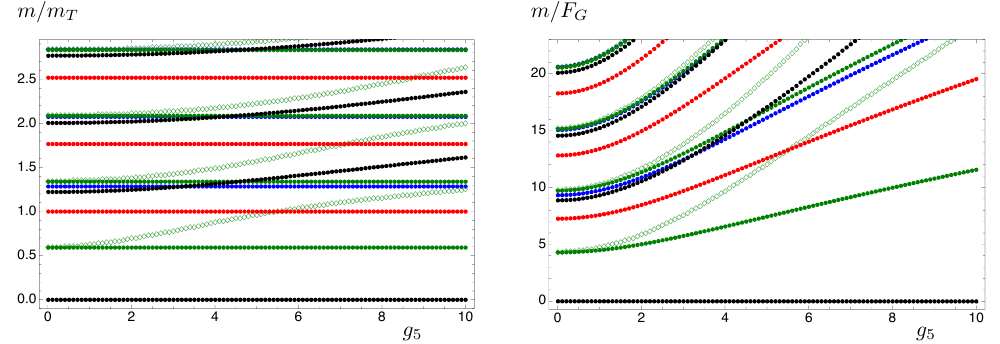
Figure 6 . Example B. Spectrum as a function of g 5 for ∆ = 3 , r 1 = 10 − 4 , r 2 = 8 . The left panel is normalized to the mass m of the lightest tensor, while the right panels are normalized to T the decay constant ˜ F = F . The colour coding is: scalar (blue), tensor (red), pseudoscalar G G /N C (black), vector (green), axial-vector (green diamonds). Since ∆ > 2 , there is also a massless dilaton in the spectrum, as can be seen from figure 5; due to the numerical resolution deployed only the Goldstone is shown in the present two